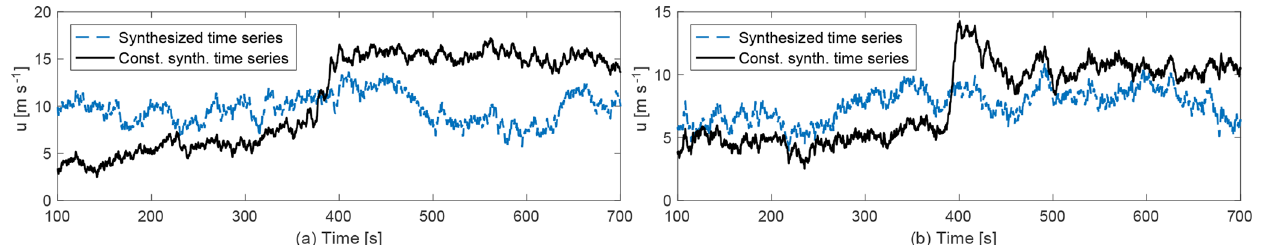
Figure 7. Comparison of unconstrained and constrained stream-wise ( u ) velocity component in the middle of the turbulence box; y = 89 . 6m, z = 119m. (a) Seed 1003. (b) Seed